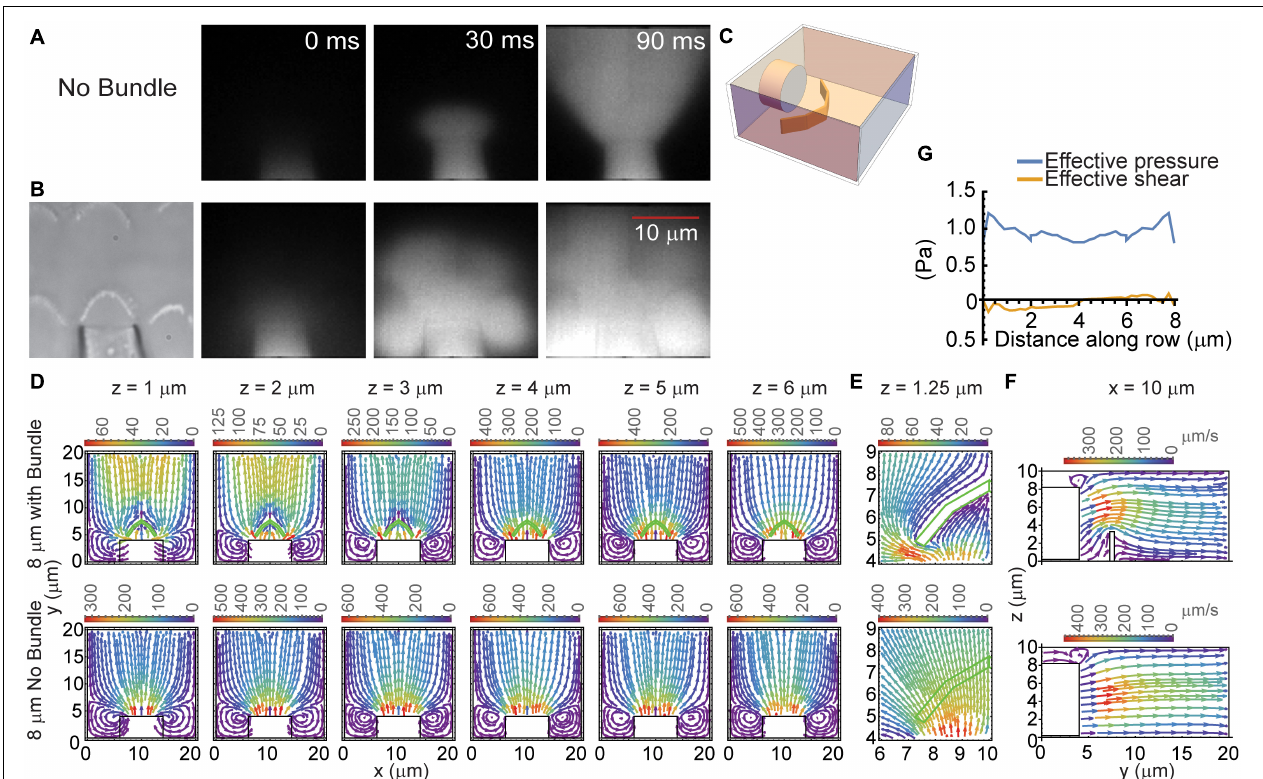
FIGURE 3 | Hair bundle effects on fluid flow. (A,B) 1 µ M Alexa 594 was used to track the flow from the fluid jet pipette. Fluorescent images at three time points corresponding to before the stimulus (0 ms), immediately after stimulus onset (30 ms), and during the stimulus (90 ms) in the absence (A) and presence (B) of the hair bundle are shown. (C) Schematic of the 3D model structure is shown. (D) Provides the FEM computed, steady-state fluid flow from a pipette of 8 µ m diameter measured at various distances above the apical surface (z) with (top row) and without the hair bundle (bottom row). The hair bundle is depicted in the green outline. The color of flow lines indicates the fluid flow rate according to the color scale above the plot. (E) Presents an enlargement of half the bundle to better show how fluid flow was impeded by the hair bundle at z = 1.25 µ m. (F) Provides a side view of the fluid flow with (top) and without (bottom) the hair bundle at the 10 µ m x position from panel (D) . (G) Presents the effective pressure and the effective shear across the face of the hair bundle. Values are plotted against the distance along the hair bundle